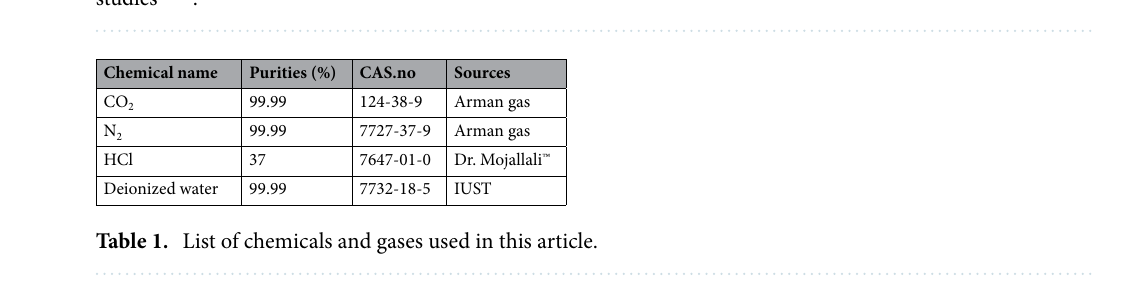
Figure 1. An overview of the simulation of various gases-liquids capture on solid adsorbents in previous studies 25–28 .